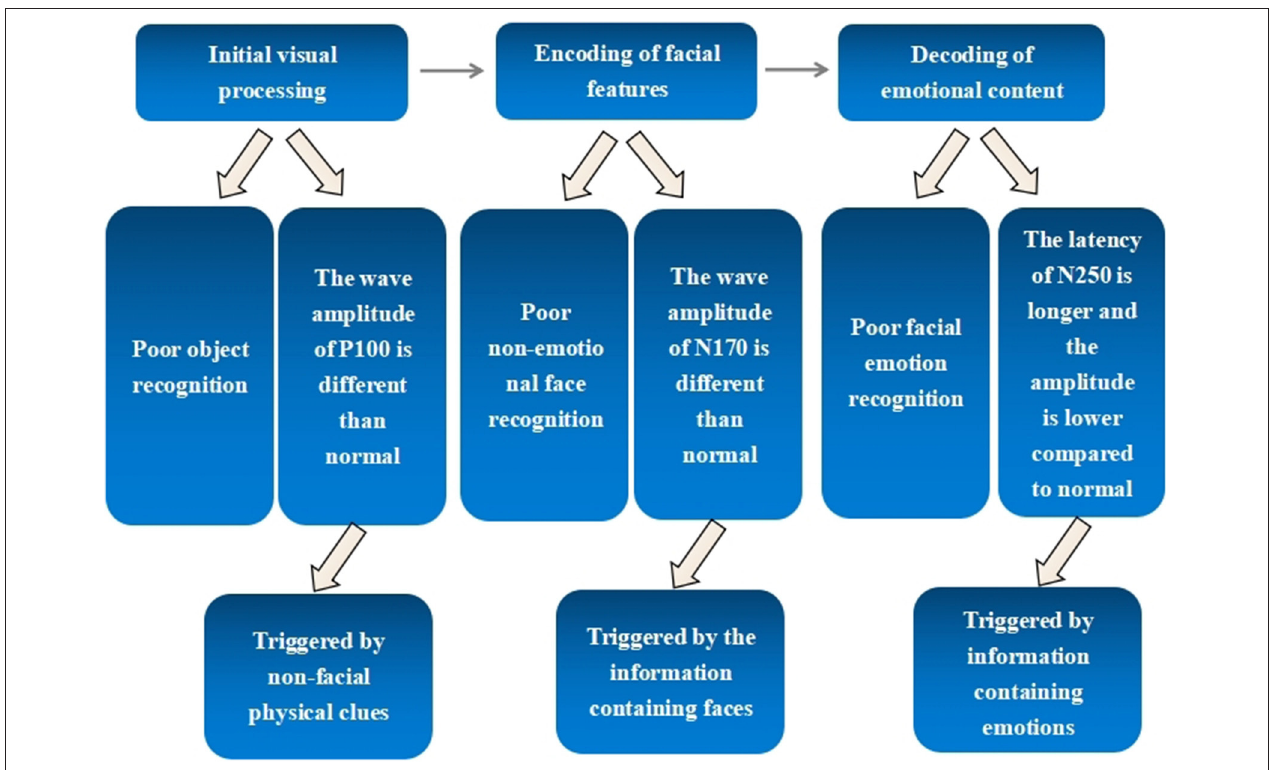
FIGURE 3 | Behavioral abilities and corresponding ERP components in three stages of facial emotion recognition processing in